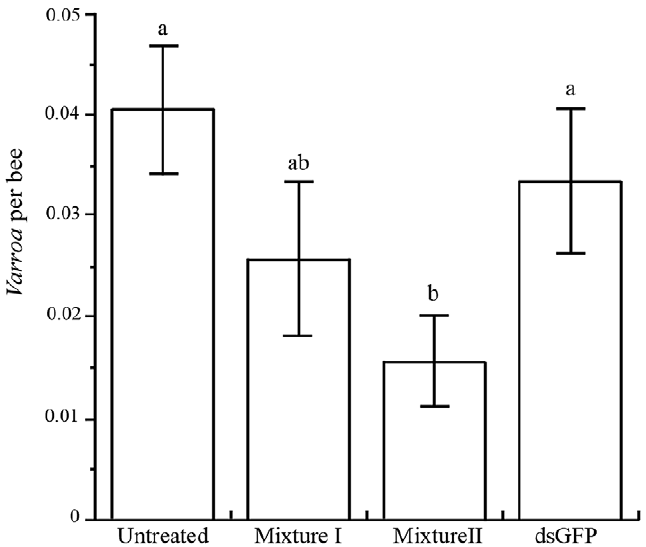
Figure 7. Mean ( + SE) number of Varroa mites per bee in four treatments. Different letters above columns indicate significant differences between treatments ( P , 0.05).